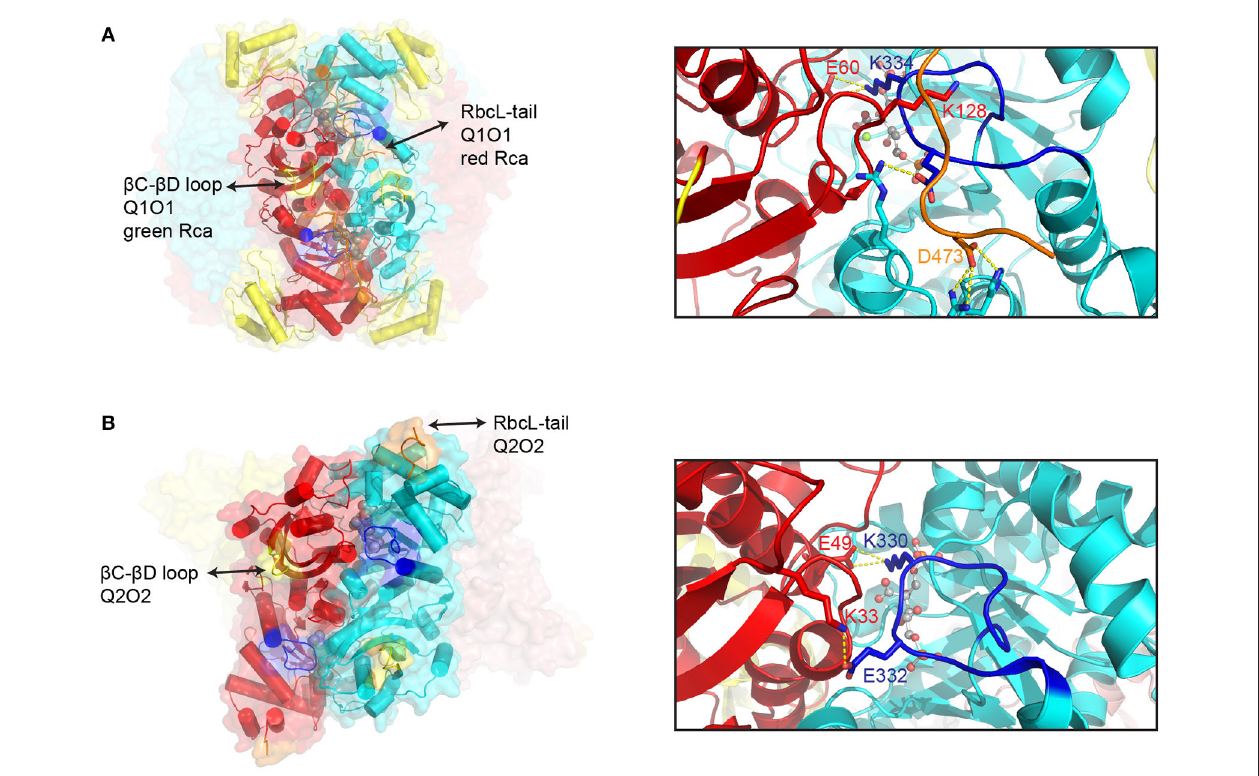
FIGURE 3 | Structural features of inhibited Rubisco complexes. A comparison of structural elements involved in the Rca-mediated activation of Form I (A) and Form II (B) Rubisco. Left panels: Surface representation of CABP-bound spinach (pdb:8ruc) and R. palustris Rubisco (pdb:4lf1). One large subunit dimer pair (in red and cyan) is shown with helices represented by cylinders. Key segments are colored as follows: β C- β D loop, yellow; Loop 6, blue; C-terminal strand, orange. Right panels: Close-up of the active site highlighting differences in Loop 6 (in blue) closure between Form I and Form II Rubisco. Key residues and interactions are highlighted. Bound CABP is shown in ball and stick representation. The following indicated residues are conserved and functionally equivalent (Form I/Form II): E60/E49; K334/K330).